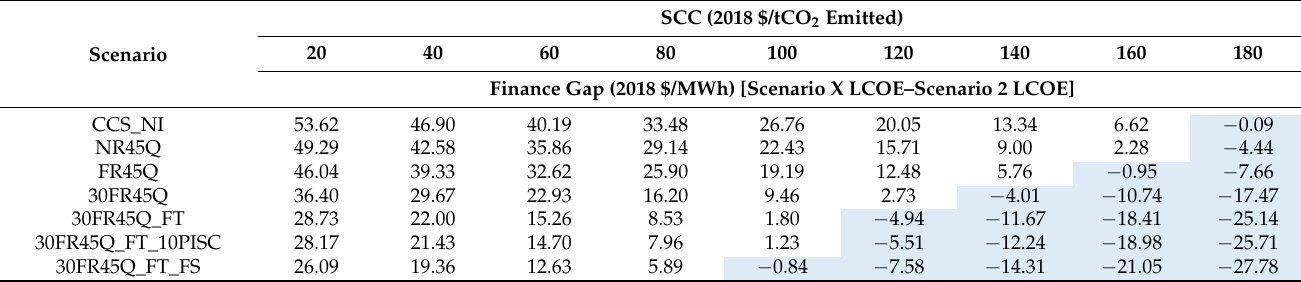
Table A9. Finance gap (2018 $/MWh) for 727-MW NGCC